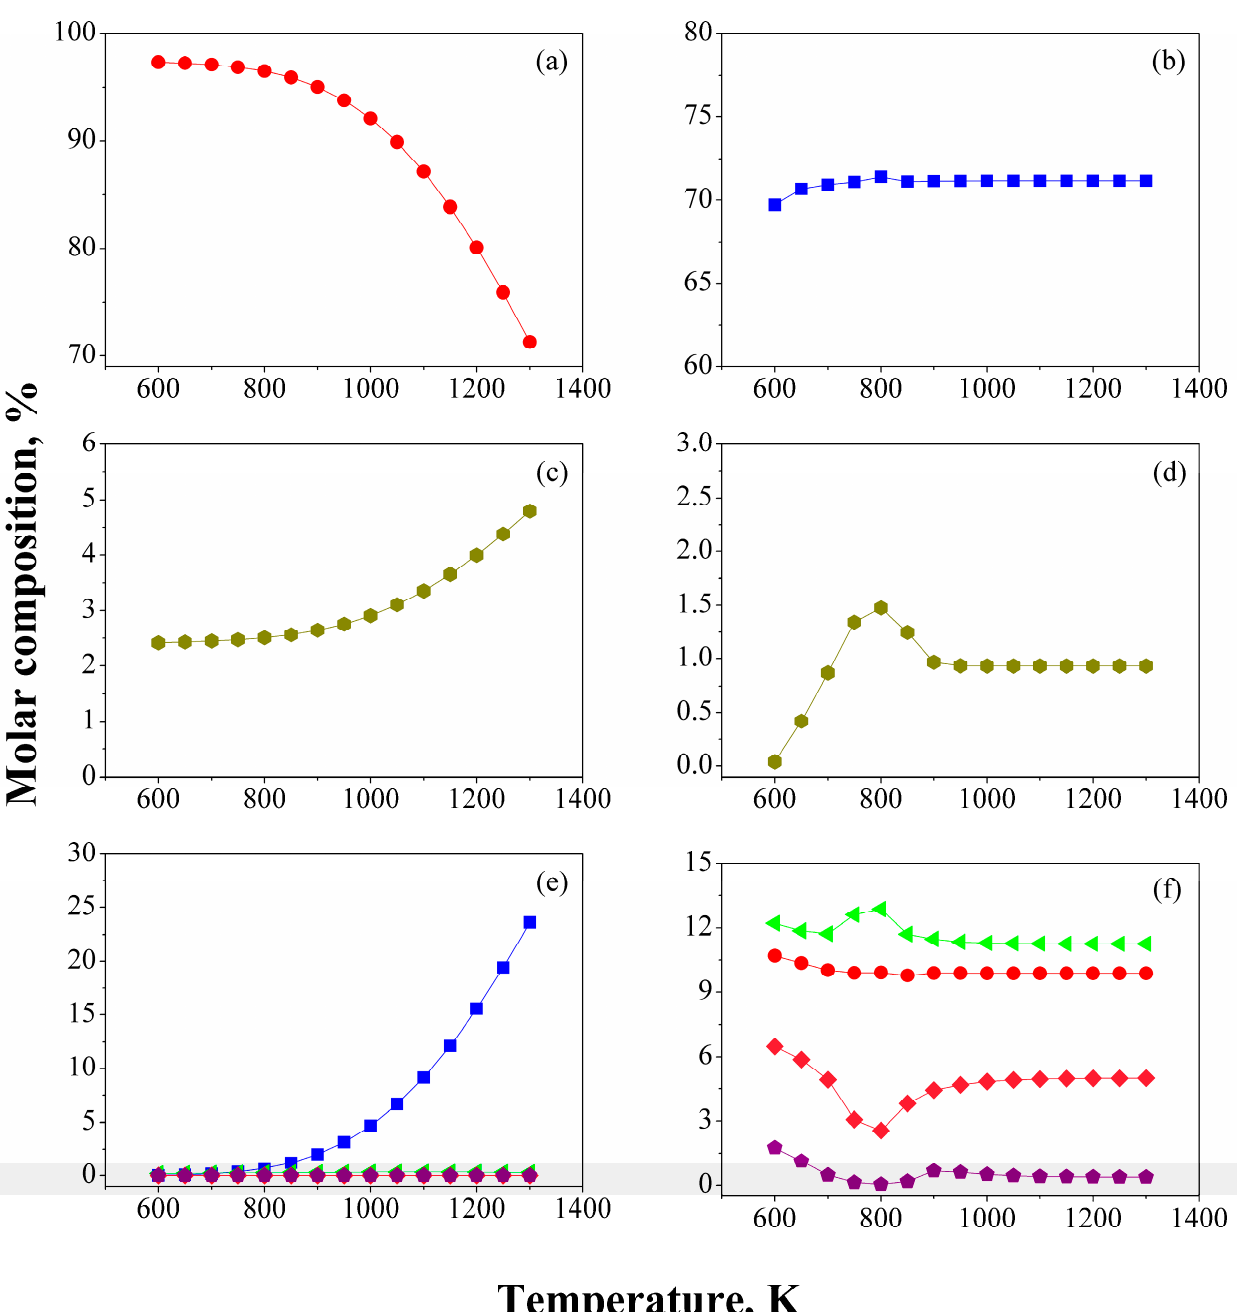
Figure 2. Effect of temperature on molar composition at 2.86 MPa and 9.4 H 2 /HC molar ratio: ( a , c , e ) Equilibrium. ( b , d , f ) Catalytic. ( ) CH 4 , ( ) H 2 , ( ) C 2 –C 5 , ( ) Paraffins, ( ) Naph- thenes, ( ) Aromatics.